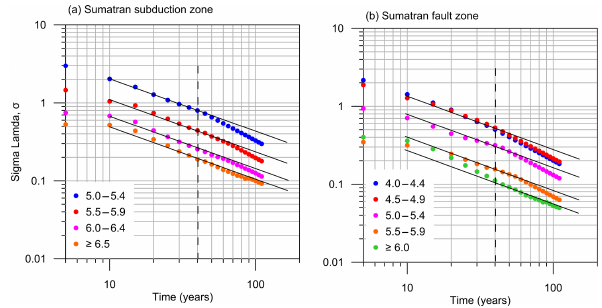
Figure 3. Seismic data completeness for (a) Sumatra subduction zone and (b) Sumatran fault